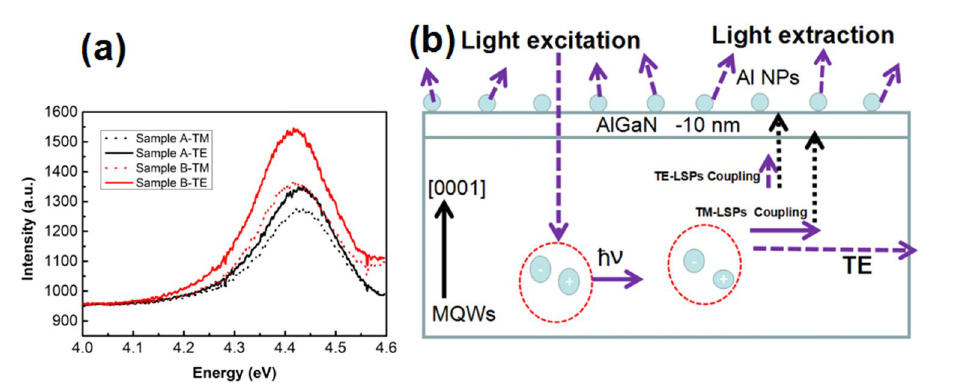
Figure 4. ( a ) Wavelength dependent Purcell enhancement ratios of TE mode and TM mode, which are calculated to describe the enhancement ratio of the radiative recombination rate; ( b ) A schematic illustration of the LSPs enhanced deep UV MQWs in this